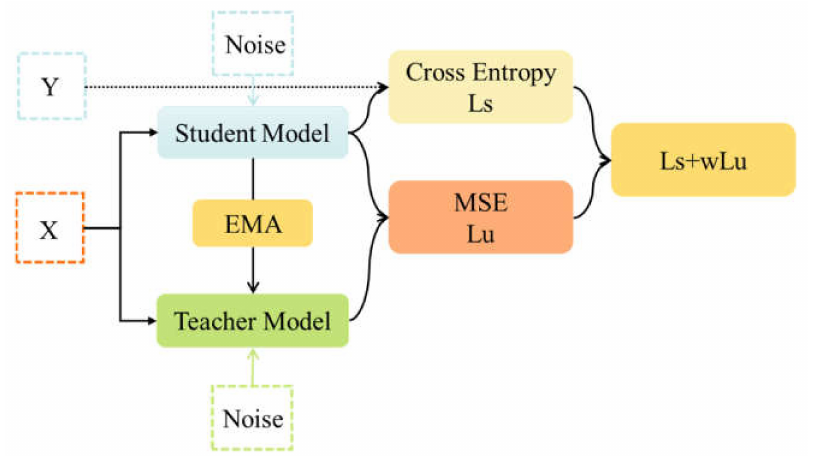
Figure 1. Scheme